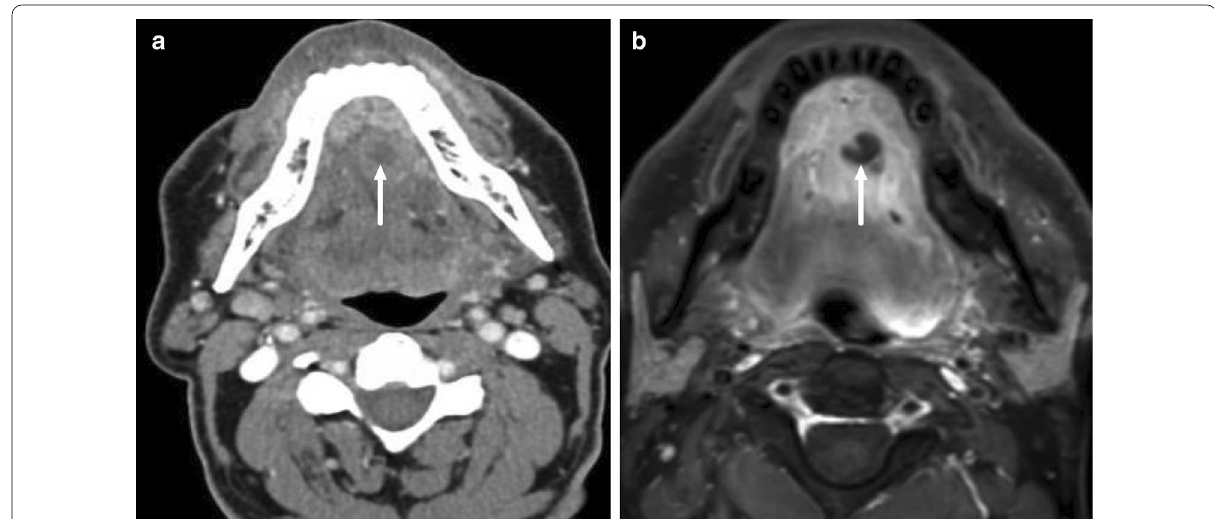
Fig. 1 The CT diagnosis of an abscess may be difficult. Images show an abscess in the floor of the mouth on axial contrast-enhanced CT ( a ), and on axial T1-weighted fat-suppressed MRI after gadolinium ( b ) from the same patient imaged within 24 h with both modalities. Subtle central hypodensity and faint rim enhancement can be seen on CT ( a ); this was, however, misinterpreted as cellulitis. A fluid collection is clearly defined within abnormal tissue enhancement on MRI ( b ), and diffusion-weighed imaging (DWI, not shown here) suggested purulence, which was confirmed by